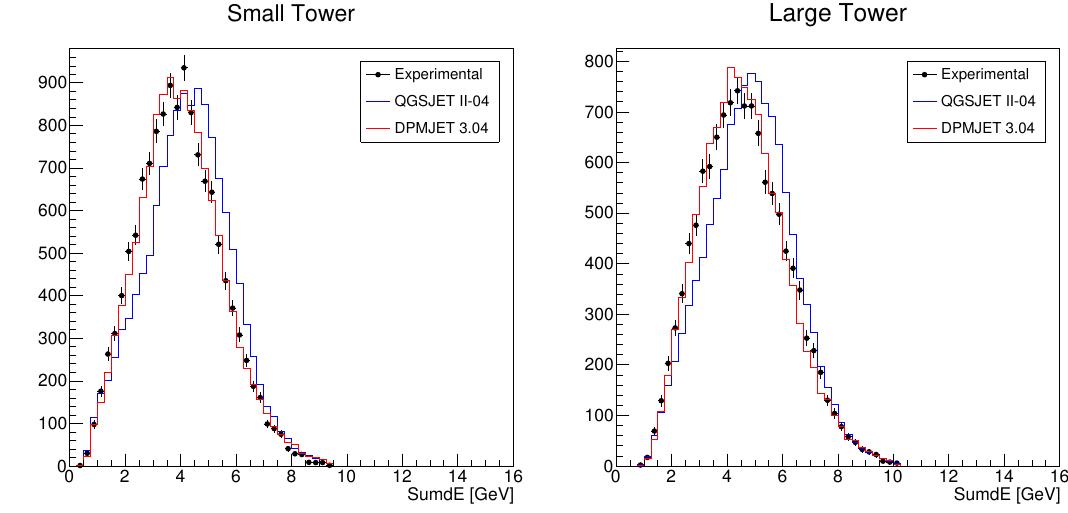
Figure 8 . Total energy deposit distributions relative to 350 GeV protons. Black points with error bars are experimental data with statistical uncertainty. Histograms refer to DPMJET 3.04 and QGSJET II-04 predictions at the detector level. Left is small tower, right is large tower.